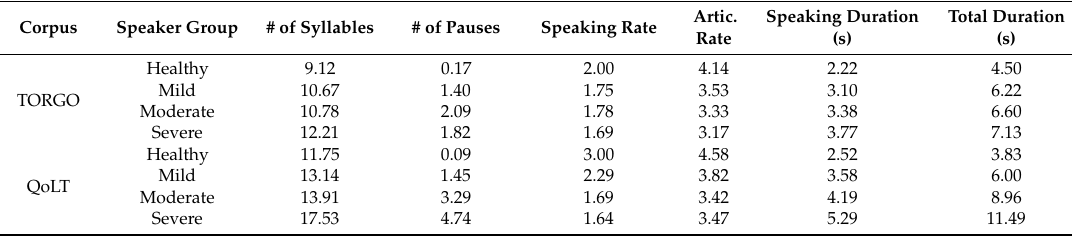
Table 3. Mean values for all speech rate measures from the QoLT and TORGO datasets.